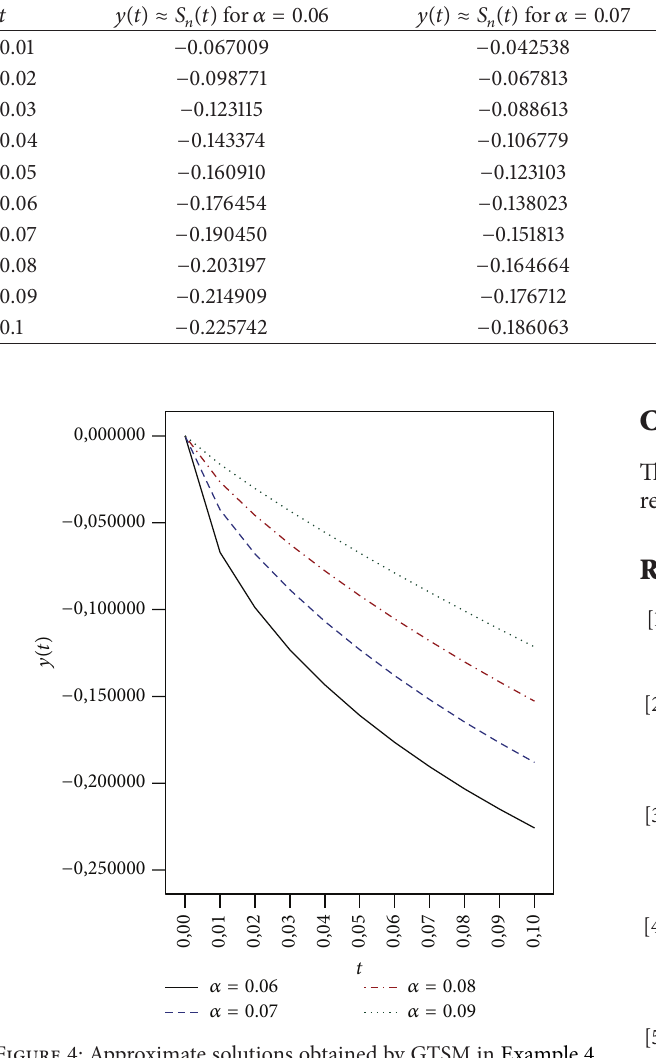
Figure 4: Approximate solutions obtained by GTSM in Example 4 for different order of